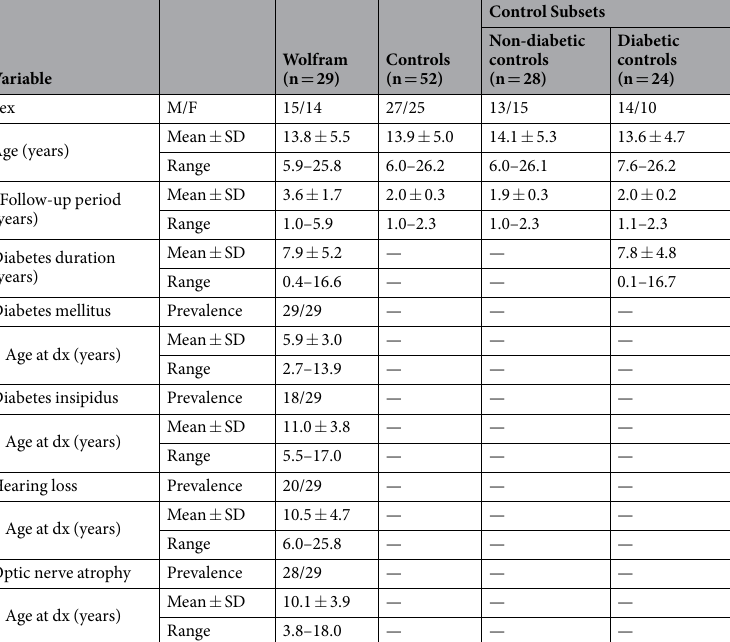
— — Table 1. Mean and standard deviation (SD) of demographic and clinical variables across Wolfram and control groups at session 1. There were no differences between the Wolfram and control groups for age (p = 0.93) or sex (p = 0.99), and there were no differences between Wolfram and the diabetic control groups for duration of diabetes (p = 0.95) at session 1. * Excludes participants with a single time point (Wolfram, n = 4; Non-diabetic